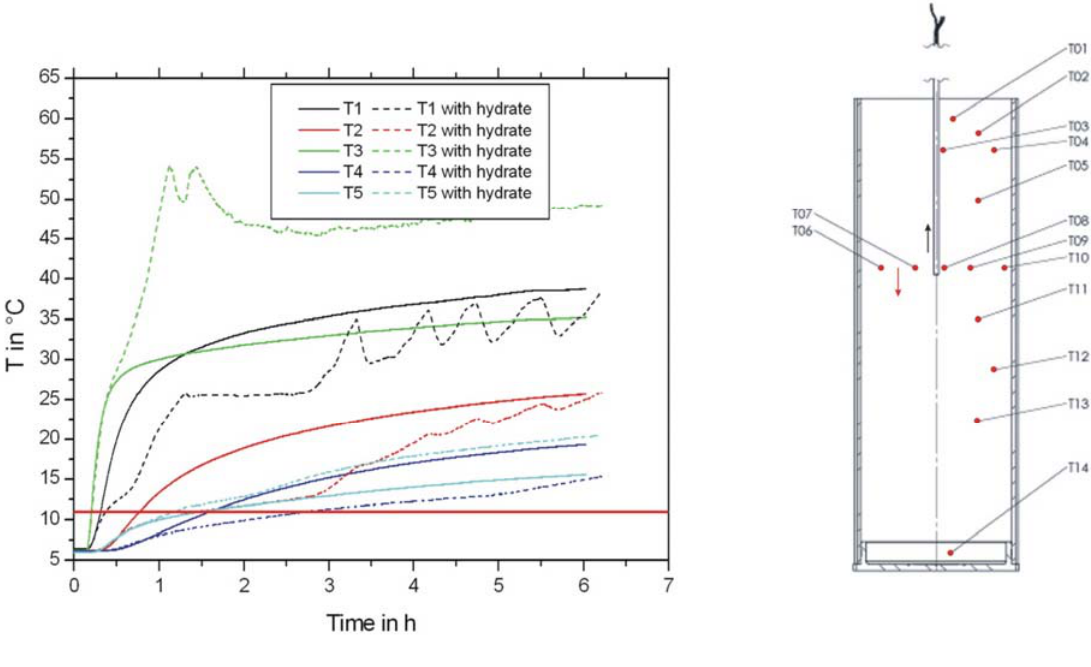
Figure 3. Comparison of temperature response of sensors T1–T5 during the heating experiments with and without hydrate. Red horizontal line shows the CH temperature at given pressure. The sketch of the sample (compare also Figure 8) shows the position of the temperature sensors during preparation which might have changed relative to the heater during sample